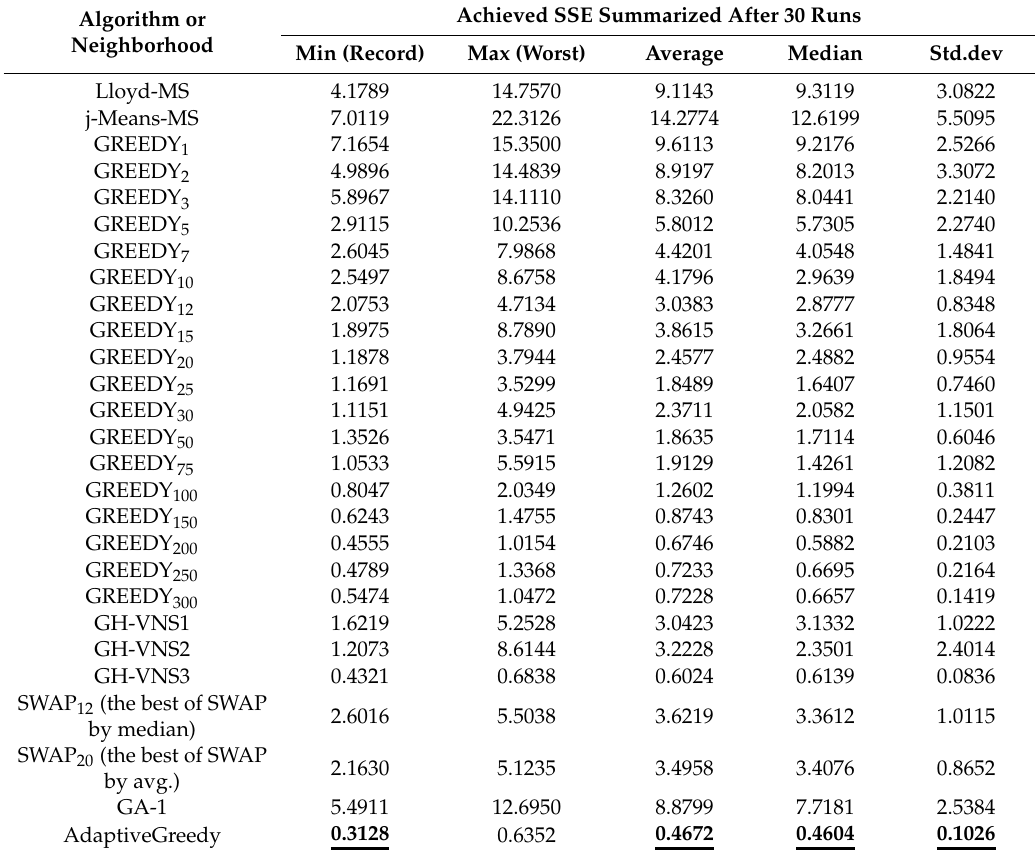
Table A3. Comparative results for Mopsi-Joensuu data set. 6014 data vectors in R 2 , k = 300 clusters, time limitation 5 s.